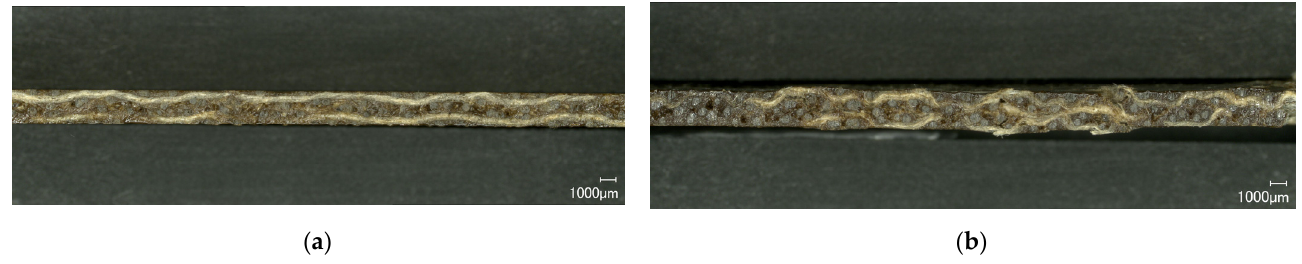
Figure 9. ( a ) Cross section showing the course of warp yarn of the FL-LI composite; ( b ) cross section showing the course of weft yarn of the FL-LI composite.